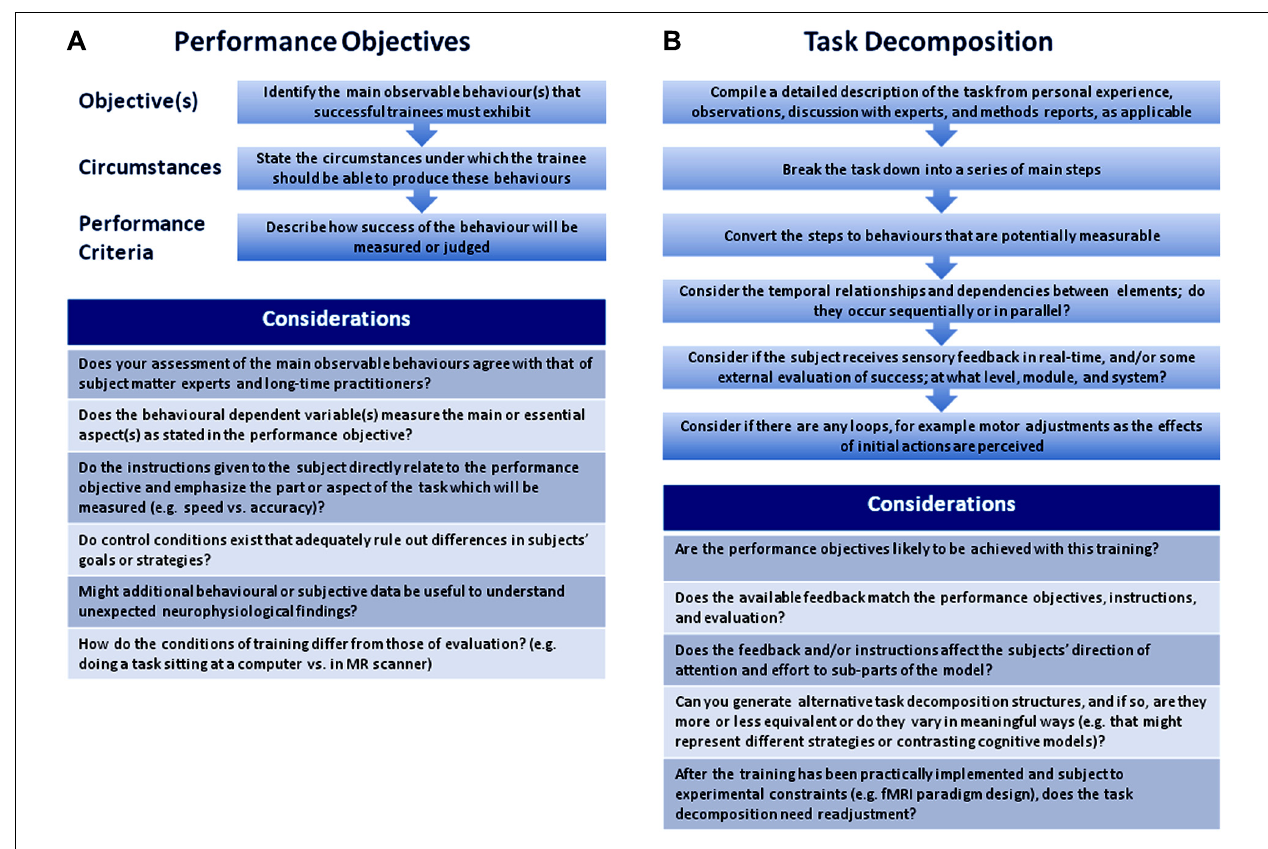
FIGURE 1 | Suggested steps and considerations for writing performance objectives (A) and for task decomposition